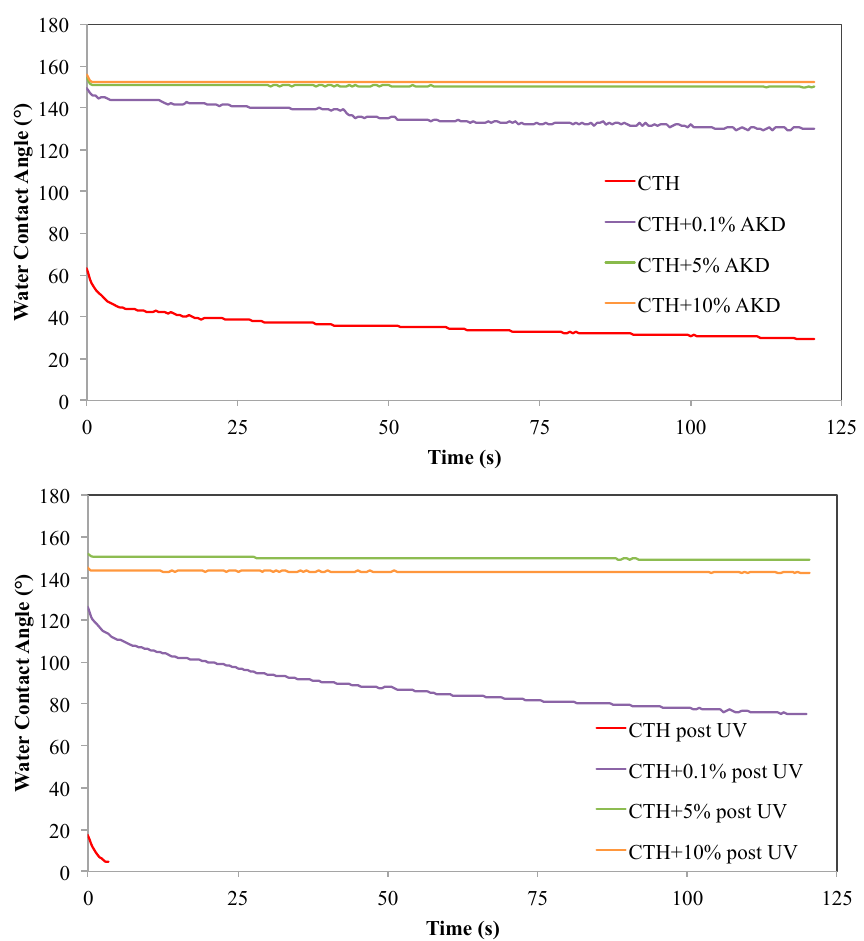
Figure 2. WCA values over time on thermally modified cedar wood samples, before ( top ) and after the UV treatment ( bottom ).